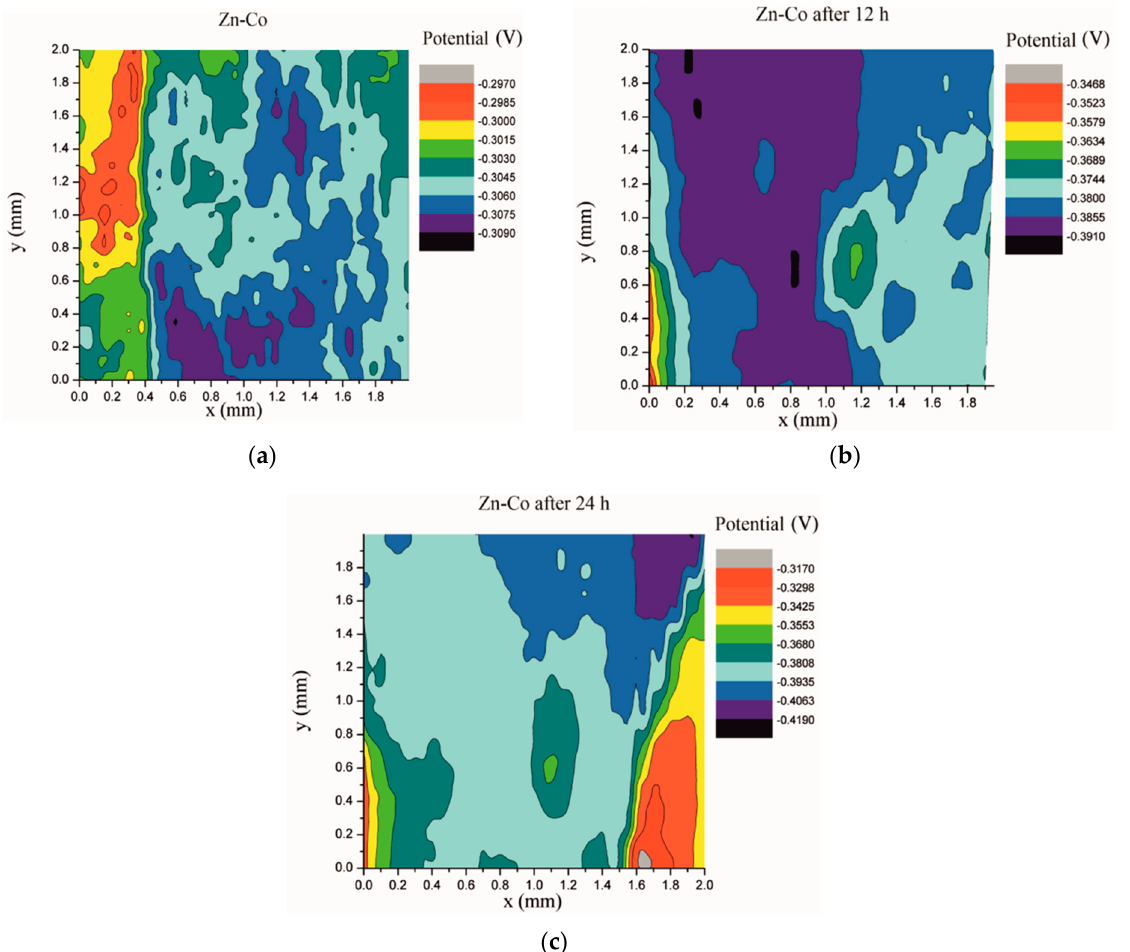
Figure 16. Volta potential difference surface scan of Zn-Co coating: ( a ) initial distribution, ( b ) after 12 h and ( c ) after 24 h in device chamber.